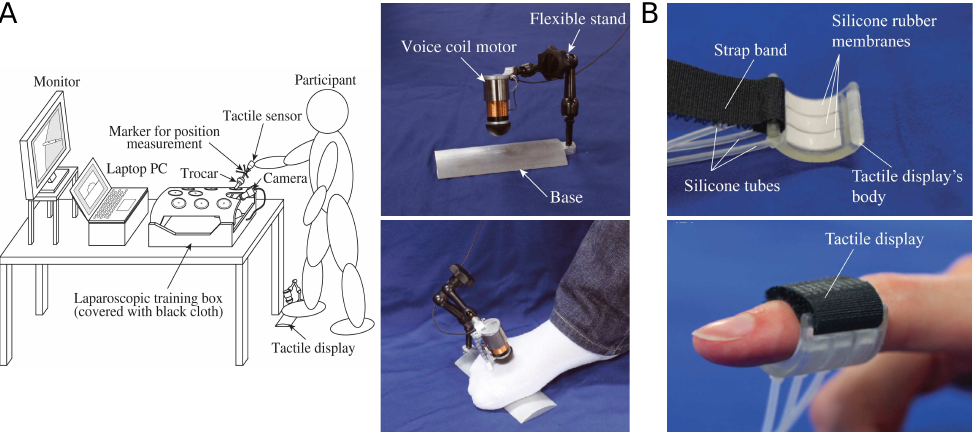
Figure 5. Skin indentation devices. ( A ) rigid tactor applies normal force to the foot [28]; ( B ) pneumatic ring proposed by Ly et al.